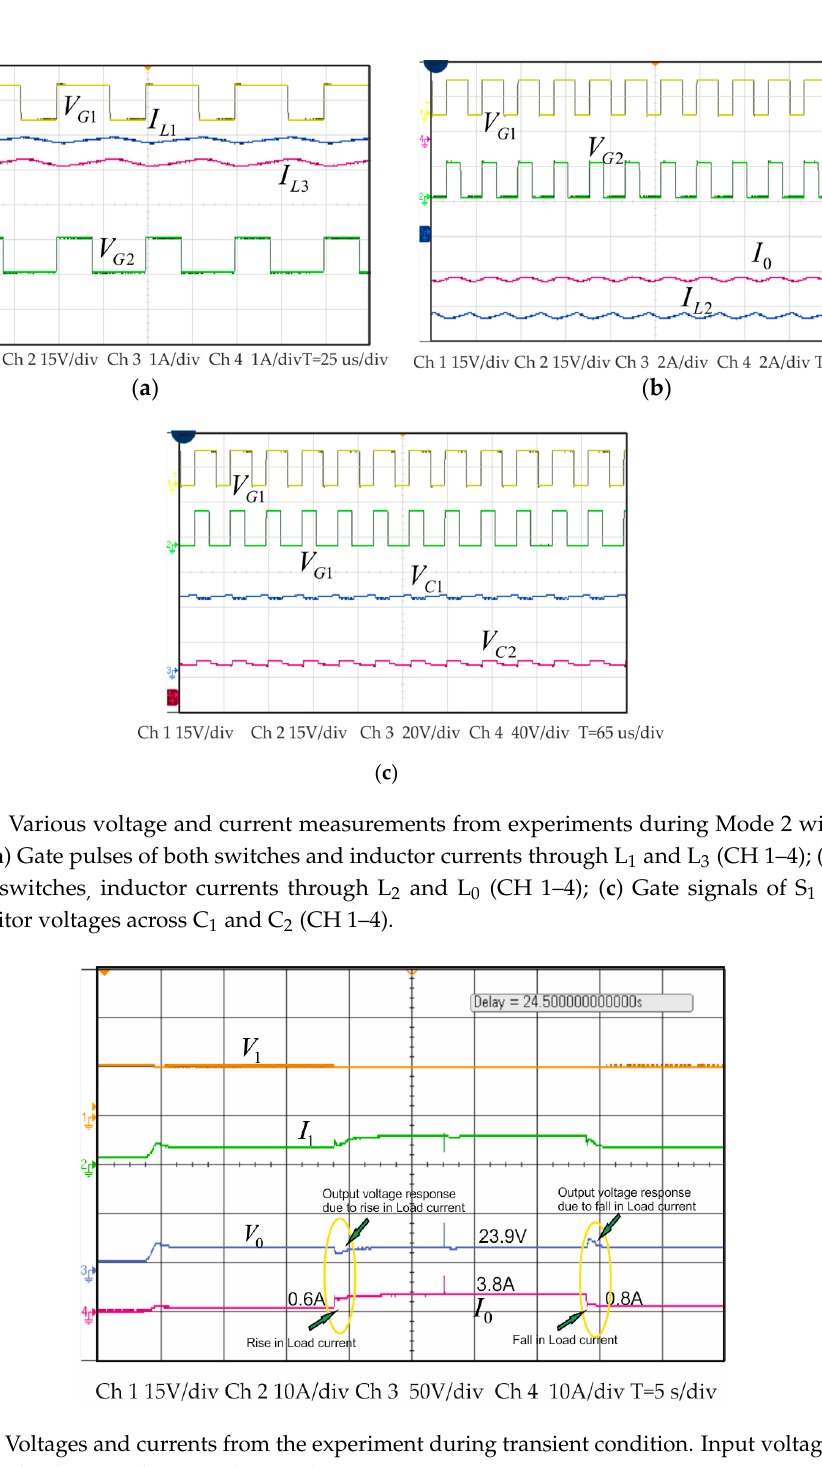
Figure 17. Voltages and currents from the experiment during transient condition. Input voltage, input current, load voltage and current (CH 1–4).